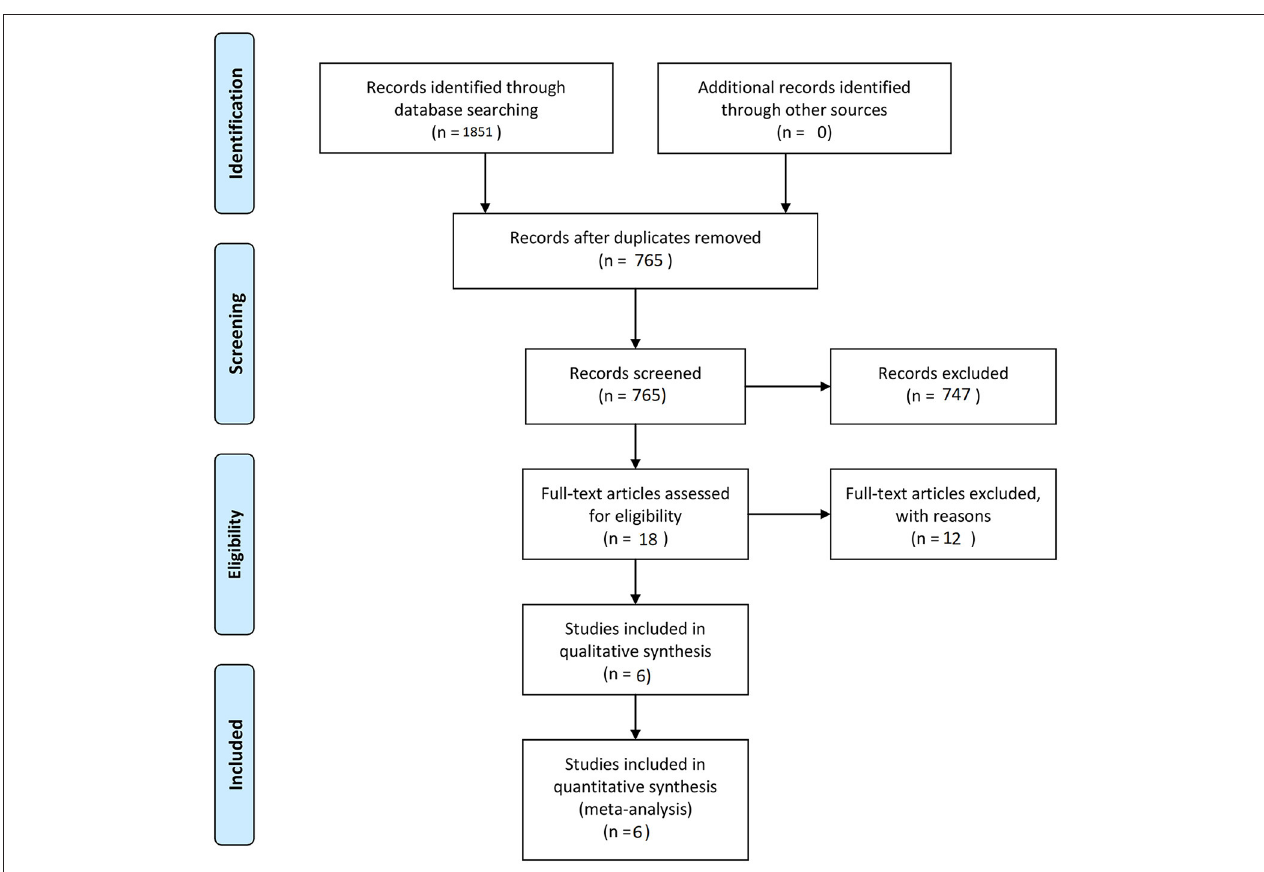
FIGURE 1 | PRISMA flow diagram of search strategy and study